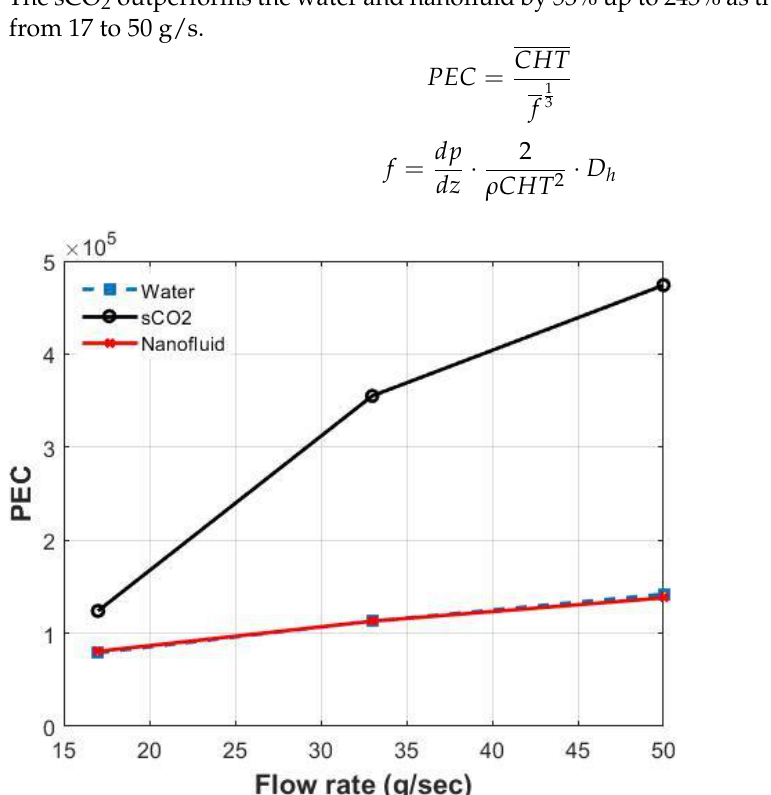
Figure 9. Performance evaluation criteria (PEC) for all coolants corresponding to different flow rates and for H f = 2 mm, t f = 1 mm and S f = 1 mm.